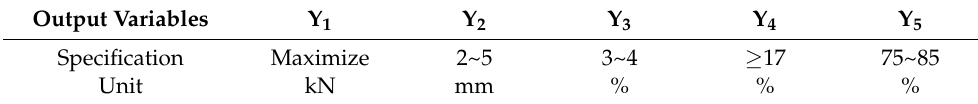
Table 3. Volumetric and physical property constrains of output